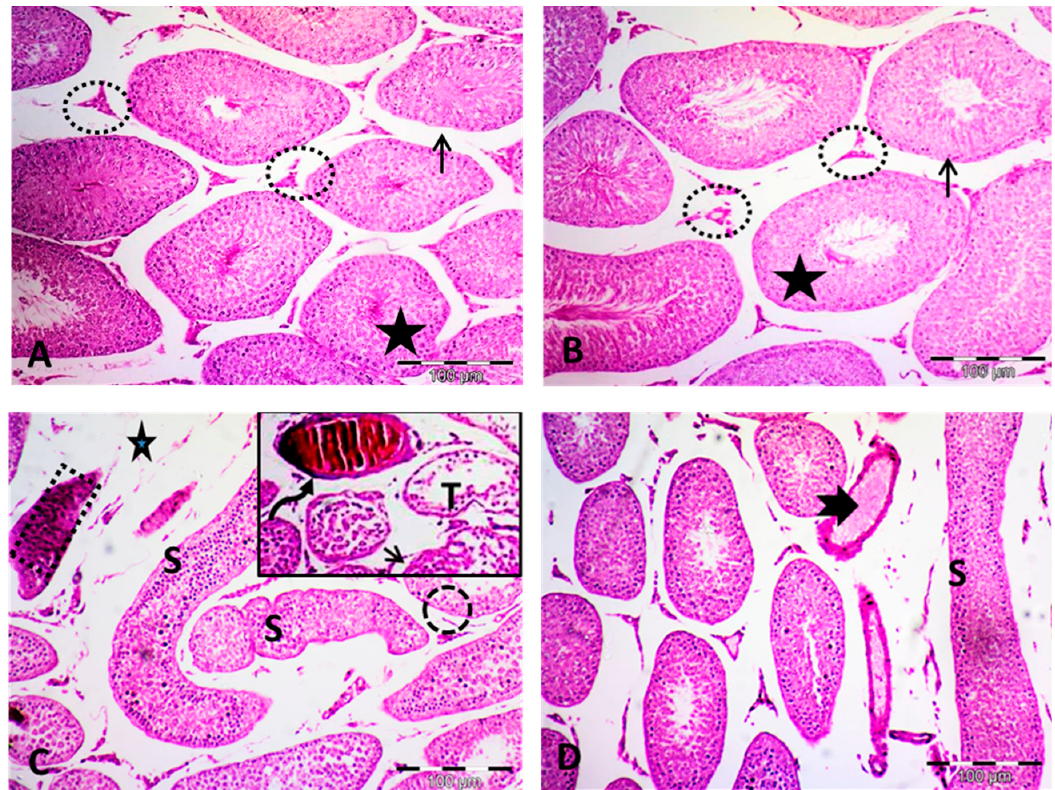
Figure 1. Photomicrographs of the testis (hematoxylin and eosin ×100). ( A and B ) Control and paeonol groups respectively, showing the same histological picture. The seminiferous tubules (stars) are seen lined with germinal epithelium. The interstitial cells of Leydig (circles) are observed between these tubules. Notice the sperms occupying the lumen of seminiferous tubules. The tubules are seen laying on the basement membrane (arrows). ( C ) MTX group showing several distorted seminiferous tubules (S) lined by darkly stained acidophilic cells (rectangle) with dense nuclei. Notice the focal reduction of the germinal cells (circle). A widened interstitium (star) is also noticed. The insert shows some tubules (T) that have nearly lost their germinal epithelium lining. The separated basement membrane (short arrow) can also be seen. Dilated congested blood vessels (curved arrow) occupying the interstitium are also noticed. ( D ) Paeonol + MTX group showing apparent normalization of the seminiferous tubules, but still few tubules appear with some distortion (S). Less widening of blood vessels (notched arrow) are seen. Table 2. Effect of paeonol on histopathological grades and spermatogenesis scoring. Group